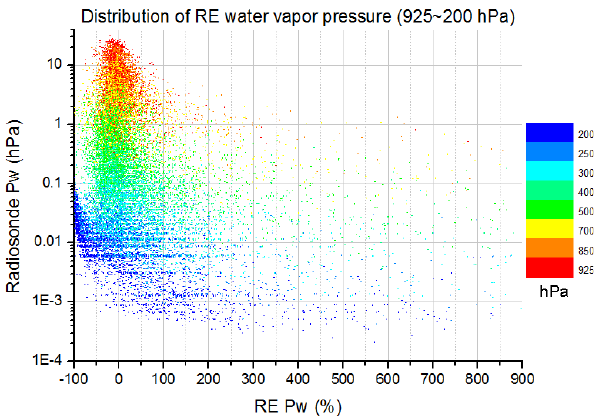
Fig. 5. Distribution of the relative error of water vapor pressure in the layers of 925 to 200hPa.